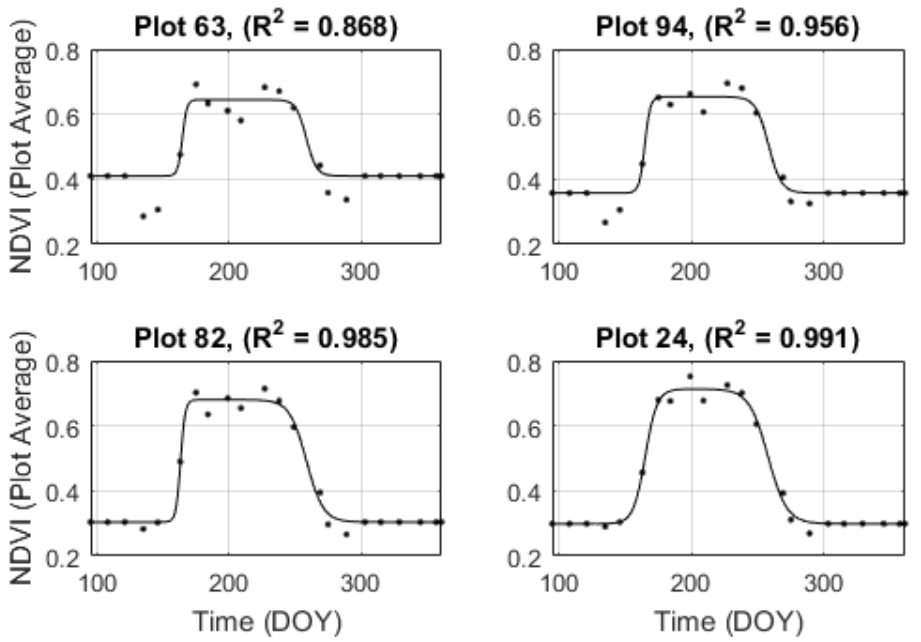
Figure 6. Four different plot-average NDVI time-series resampled to a 13-day average revisit interval and fit to the asymmetric double sigmoid